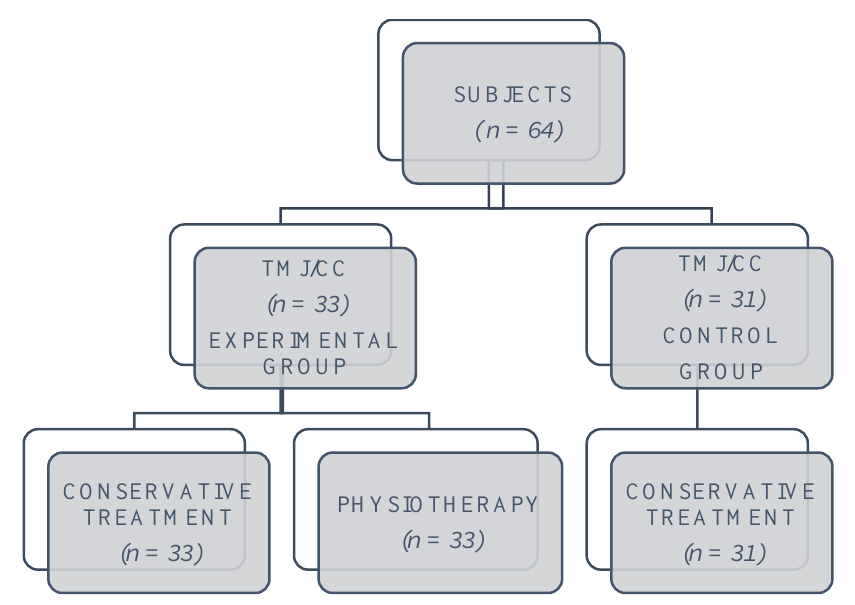
Figure 1. Group Design — Flowchart.